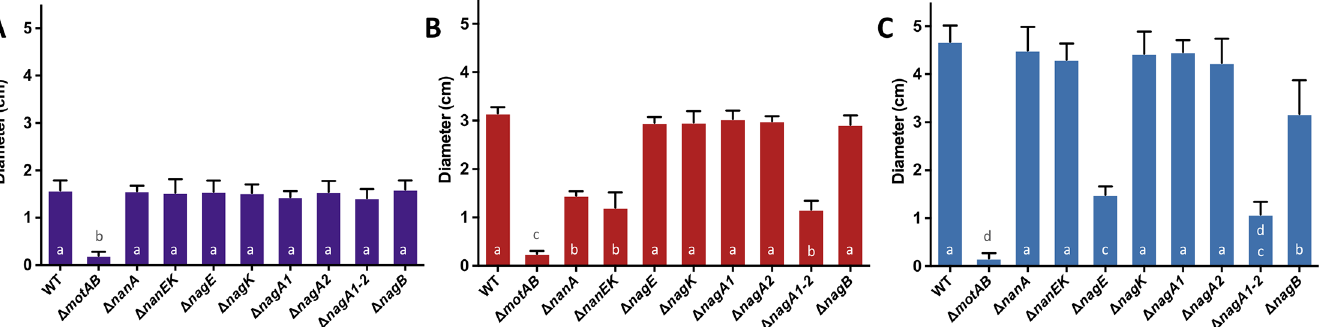
Fig 3. Motility of V . cholerae mutants in the presence of Neu5Ac and GlcNAc. The motility responses of different mutants involved in the catabolism of Neu5Ac and GlcNAc were tested on soft agar plates containing A) 0.1% glycerol or 0.1% glycerol supplemented with B) Neu5Ac and C) GlcNAc. Columns represent the mean of four independent experiments and error bars the standard deviation. Wild-type N16961 (WT), Δ motAB (non-motile), Δ nanA and Δ nanEK (cannot use Neu5Ac as a carbon source), Δ nagE and Δ nagK (cannot use exogenous or endogenous GlcNAc as a carbon source respectively), Δ nagA1-A2 and Δ nagB (cannot use Neu5Ac or GlcNAc as carbon sources). Statistical comparisons were made using one-way ANOVA and comparing diameters of the mutants relative to wild-type using Tukey’s HSD test; bars within a panel with the same letter are not significantly different at alpha = 0.05. In A bars with the letter a are not significantly different at alpha = 0.05 from one another but are different from b at P < 0.0001. In B bars with the letter a are not significantly different at alpha = 0.05 from one another but are different from b and c at P < 0.0001. Furthermore, b and c are also significantly different from each other with a P < 0.0001. In C bars with the letter a are not significantly different at alpha = 0.05 from one another but are different from b, c and d at P < 0.0001. Furthermore, b and c are also significantly different from each other with a P <